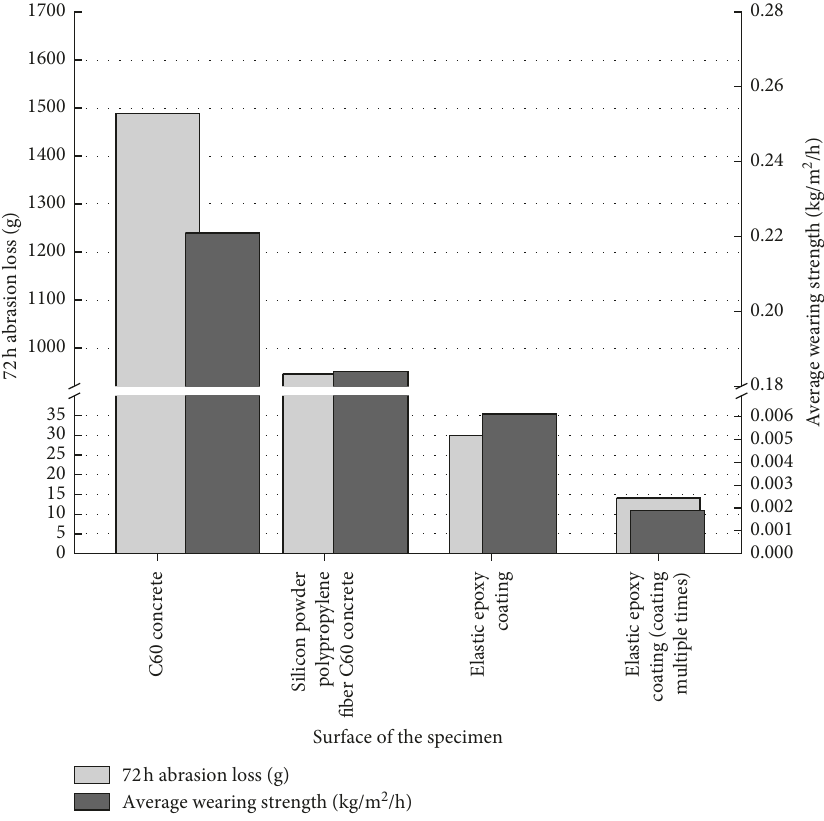
Figure 11: Average wearing strength and 72h abrasion loss of the specimens.